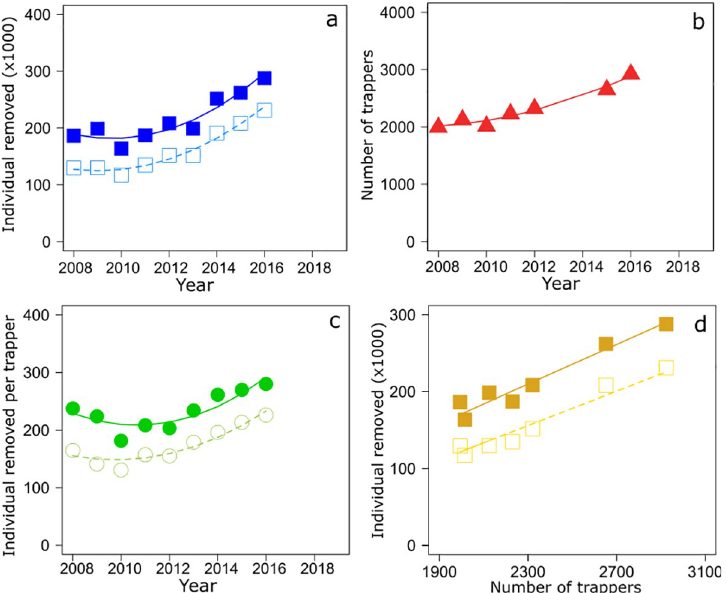
Fig 2. Temporal dynamics of captures of aquatic invasive alien rodents (AIAR) in the region Pays de la Loire. Variation over time in (a) the number of AIAR (full blue square) and coypus only (open square) trapped, (b) the number of trappers, and (c) the number of AIAR (full green dot) and coypus only (open dot) removed per trappers. Variation in (d) of the number of AIAR (full golden square) and coypus only (open square) trapped with the number of trappers. Curved lines represent significant trends from generalized least squares (GLS) models with an autoregressive moving average term (see S2 and S3 Tables for statistical details).